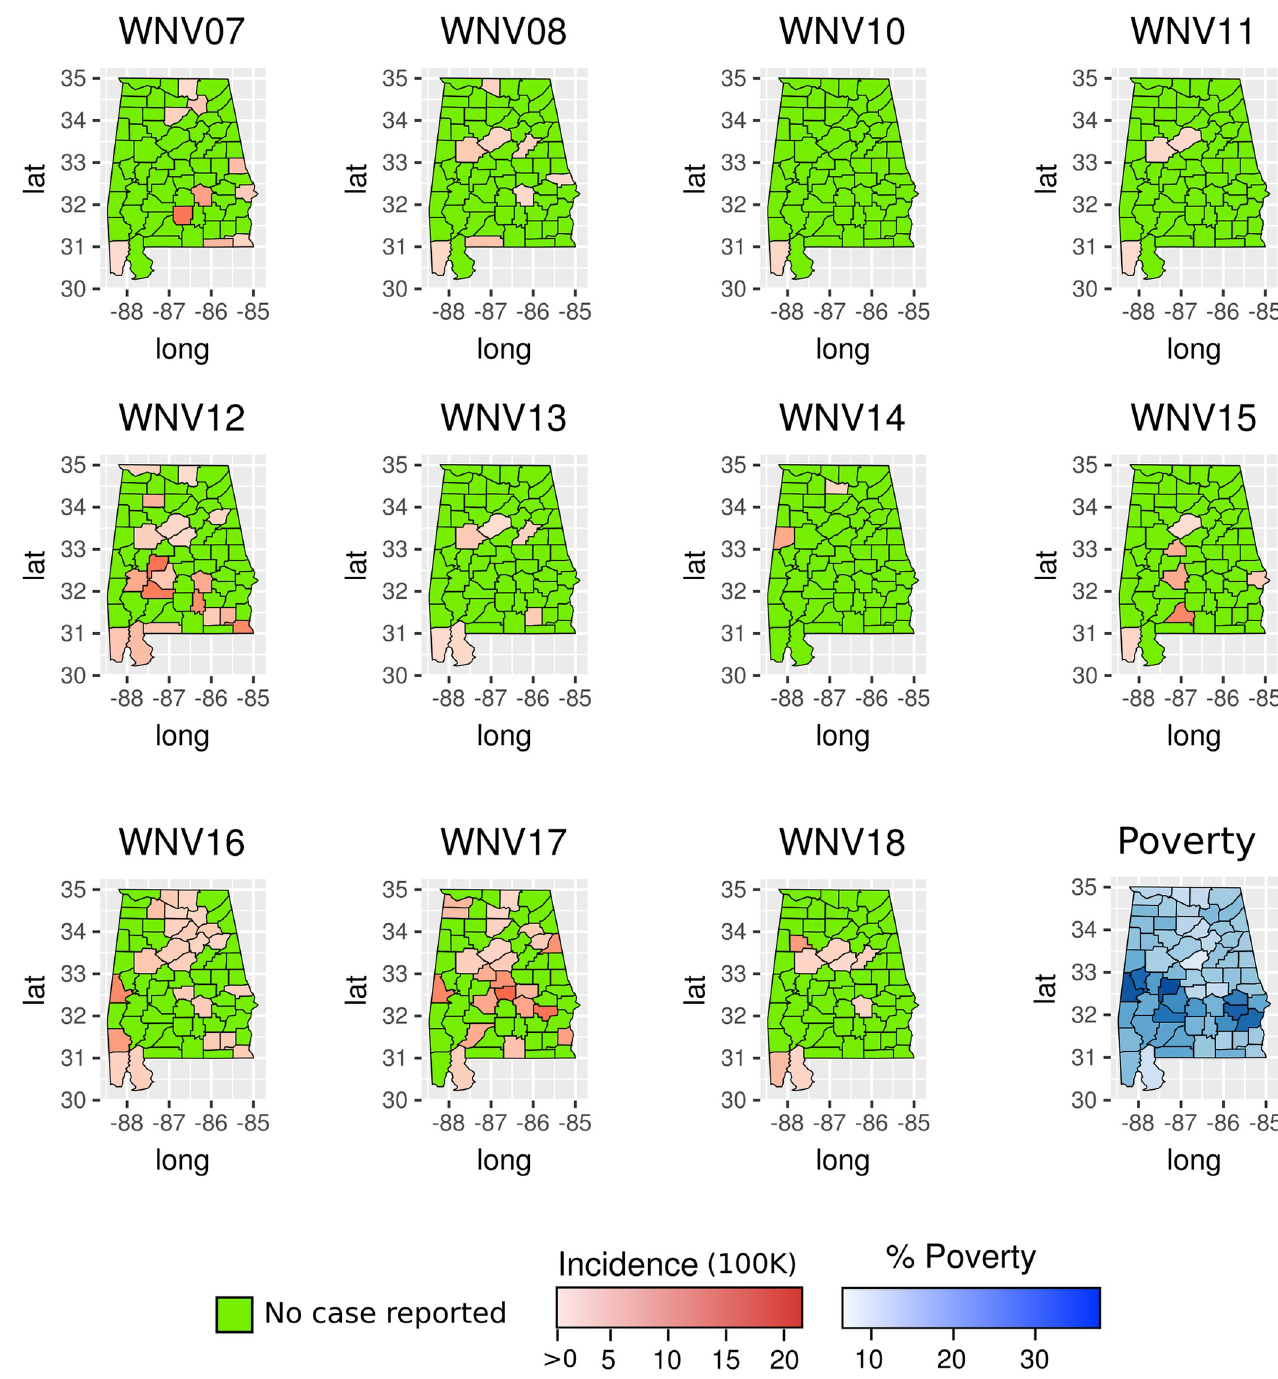
Fig 1. Incidence of West Nile Virus (WNV) at county level in Alabama from 2007 to 2017. The maps show the years when human cases were reported. The figure also includes the percentage of the population living in low socio-economic status at county level based on census data. The maps were created using public available county boundaries downloaded from www.usgs.gov processed with the R software [25].